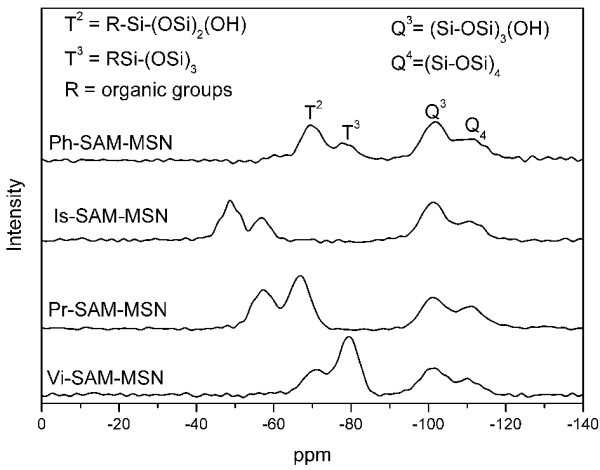
29Si -MAS NMR spectra of the different SAM-MSNs.